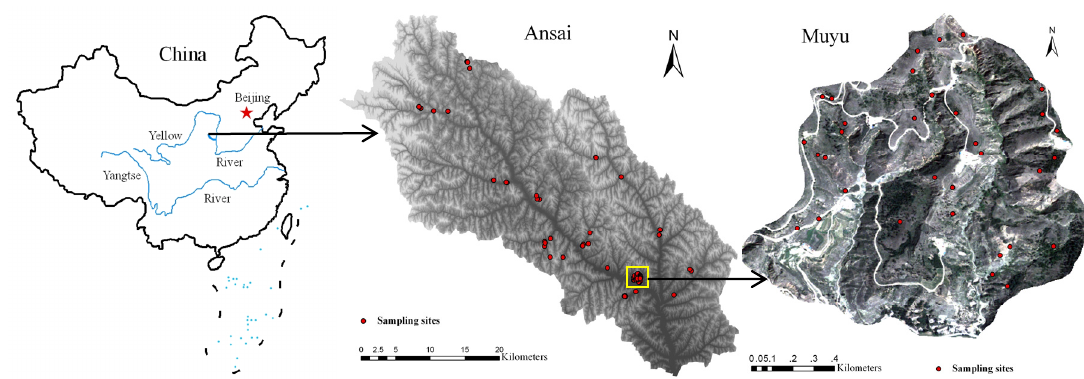
Figure 1. Study area and location of the sampling